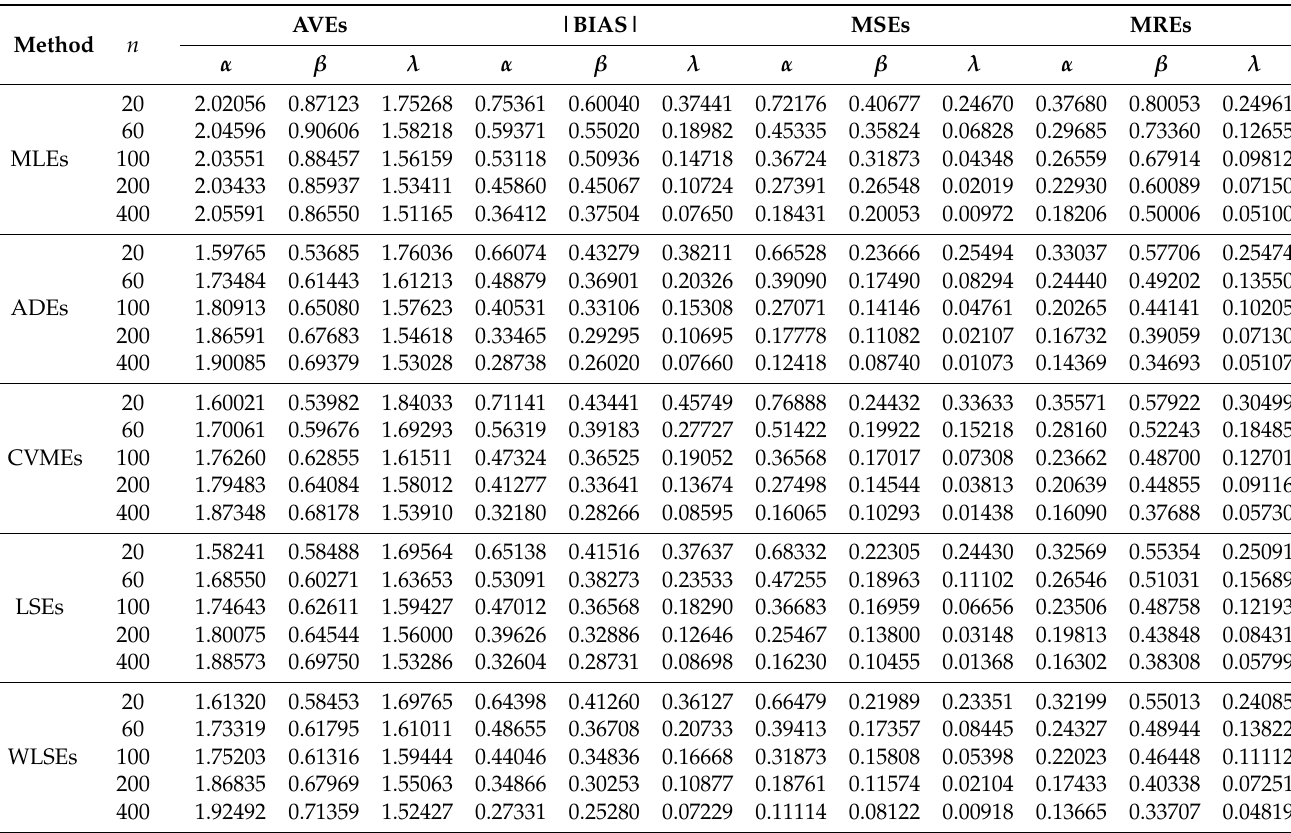
Table 9. Numerical values of the Ex-LL distribution for the parameters α = 2, β = 0.75, λ =